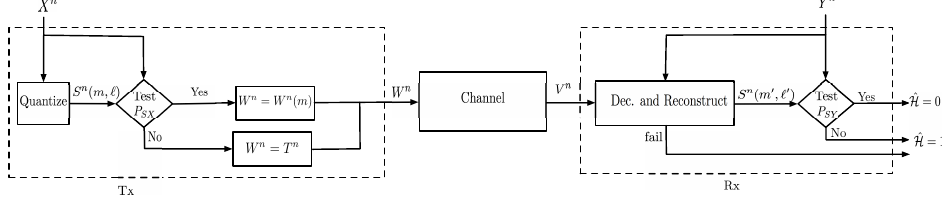
Figure 2. Coding and testing scheme for hypothesis testing over a